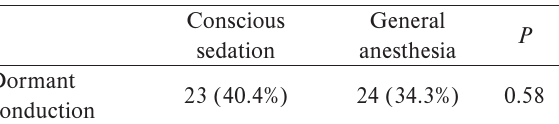
Table 4. The presence of adenosine-mediated dormant conduction.